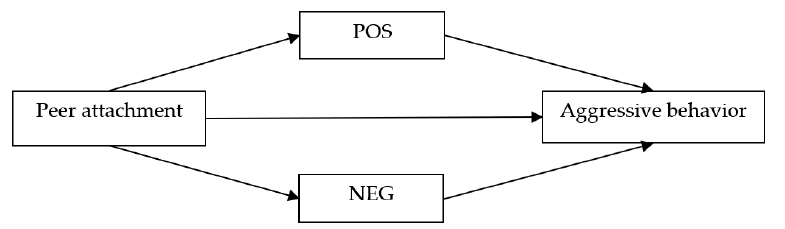
Figure 1. The proposed conceptual model of peer attachment, regulatory emotional self-efficacy, and aggressive behavior. POS, self-efficacy in expressing positive emotions; NEG, self-efficacy in managing negative emotions.